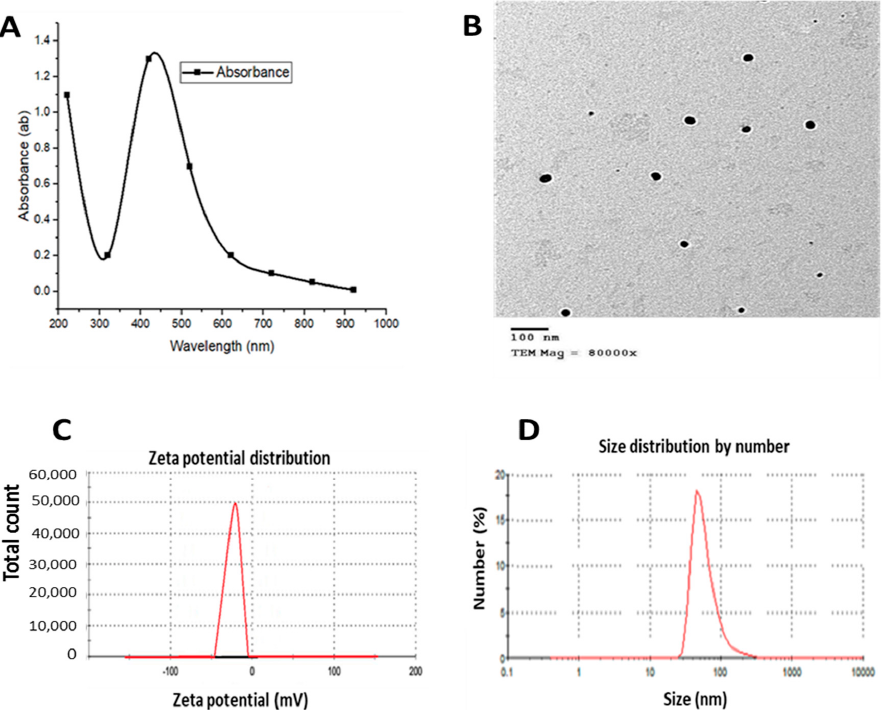
Figure 1. Characterization of AgNPs. ( A ) UV–Vis spectroscopy shows the maximum peak at 420 nm, ( B ) TEM analysis reveals a spherical shape 30–60 nm average size, ( C ) the zeta potential analysis shows a − 22 mV net surface charge, ( D ) the DLS analysis shows a hydrodynamic size of 59 nm. Biomedicines 2023 , 11 , x FOR PEER REVIEW Regarding the QNPs, TEM analysis revealed a spherical shape absorbing UV at 310 nm, an average size of 45–65 nm, and a net surface charge of − 23 mV. DLS analysis showed an exact size of 77 nm (Figure 2).